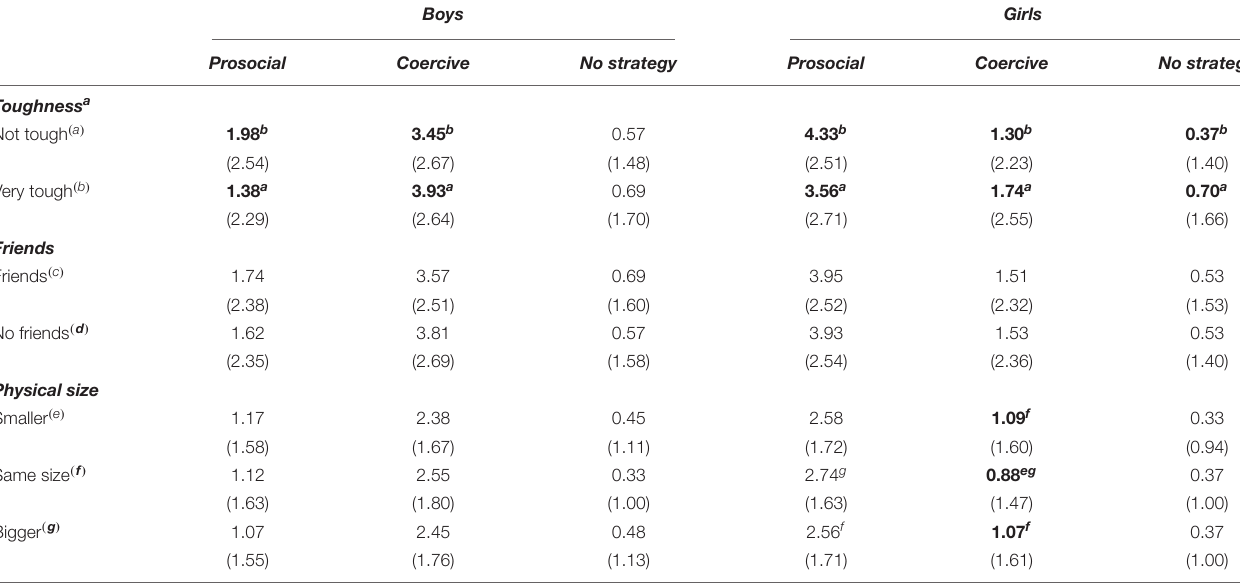
FIGURE 2 | Overall gender differences in response frequency in the RHP vignettes measure. Significance *** ( p > 0.001) refers to comparison of response type between genders (shown by the three bar clusters). TABLE 3 | Repeated-measures ANCOVA post hoc analyses for RHP vignette responses and opponent characteristics. Boys